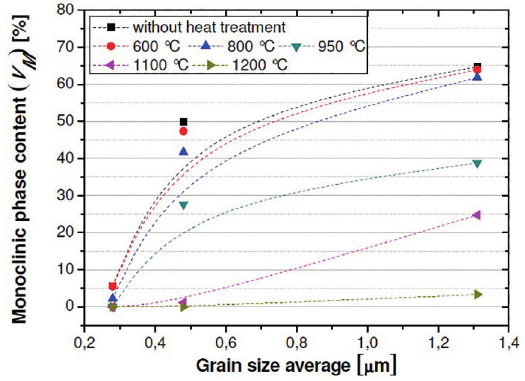
Figure 6: Volume fraction of monoclinic phase ( V grain size for different heat treatments